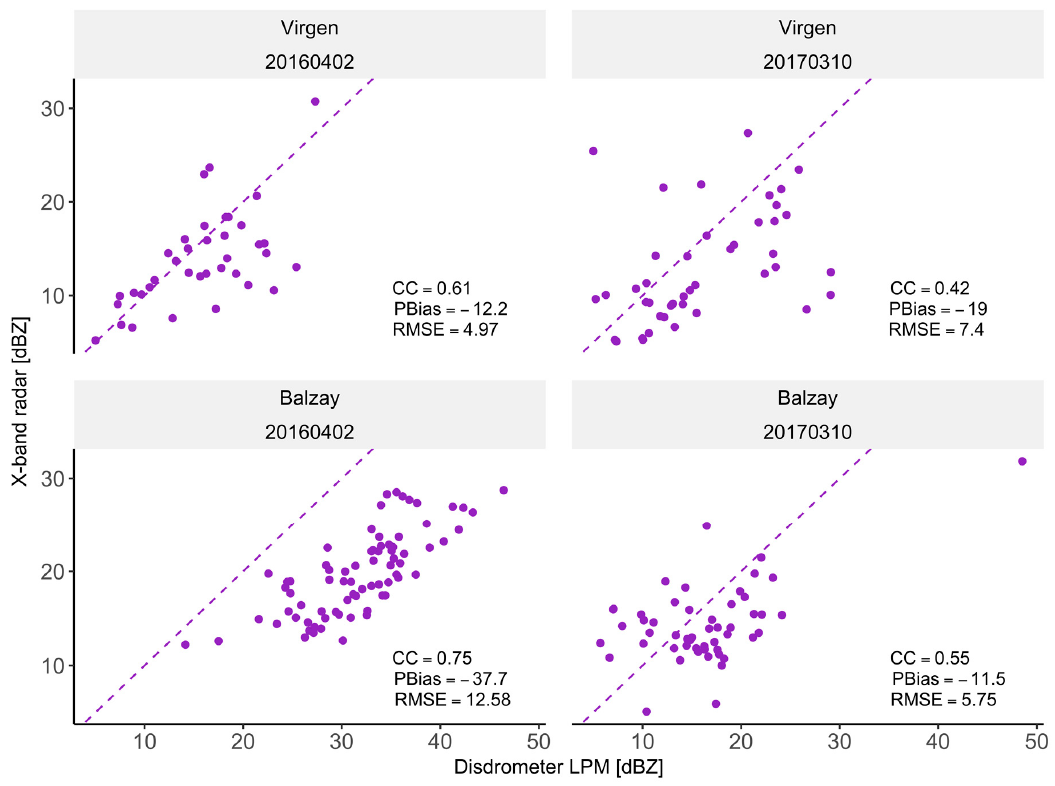
Figure 3. Reflectivity [dBZ] as recorded by both disdrometers at Virgen (7 km) and Balzay (30 km) from the radar location in comparison with the X-band CAXX measurements (> = 5 dBZ) for two rainfall events. Pearson’s correlation coefficient (CC), percentage bias (PBias) and root mean squared error (RMSE) are illustrated.